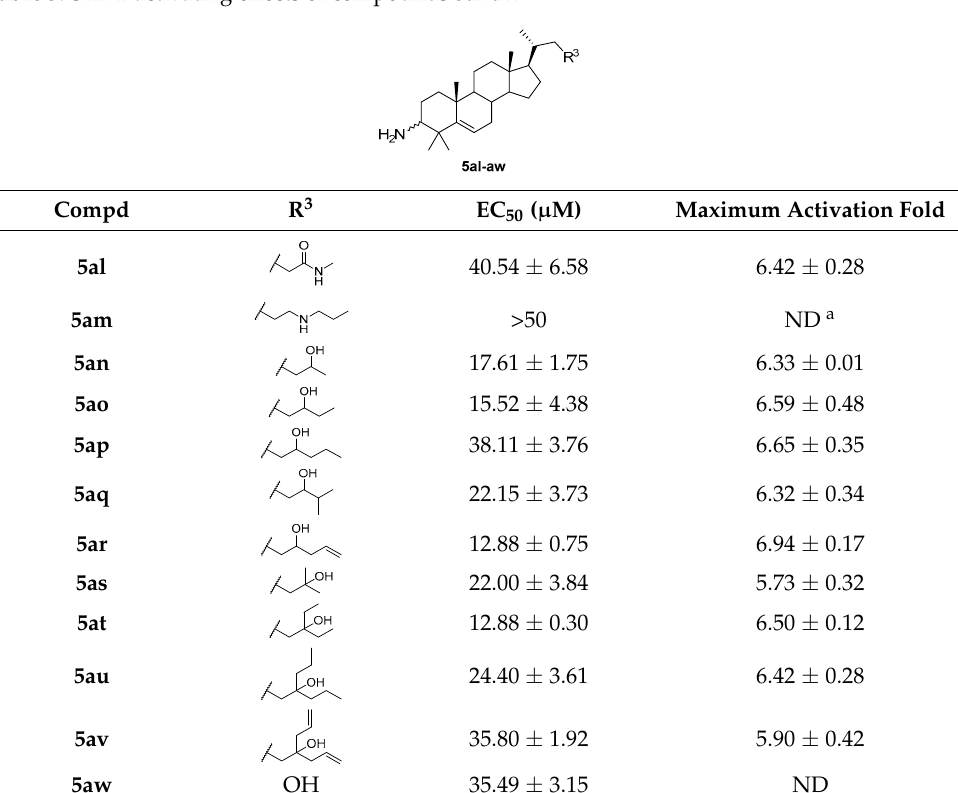
Table 3. SHP1-activating effects of compounds 5al-aw .